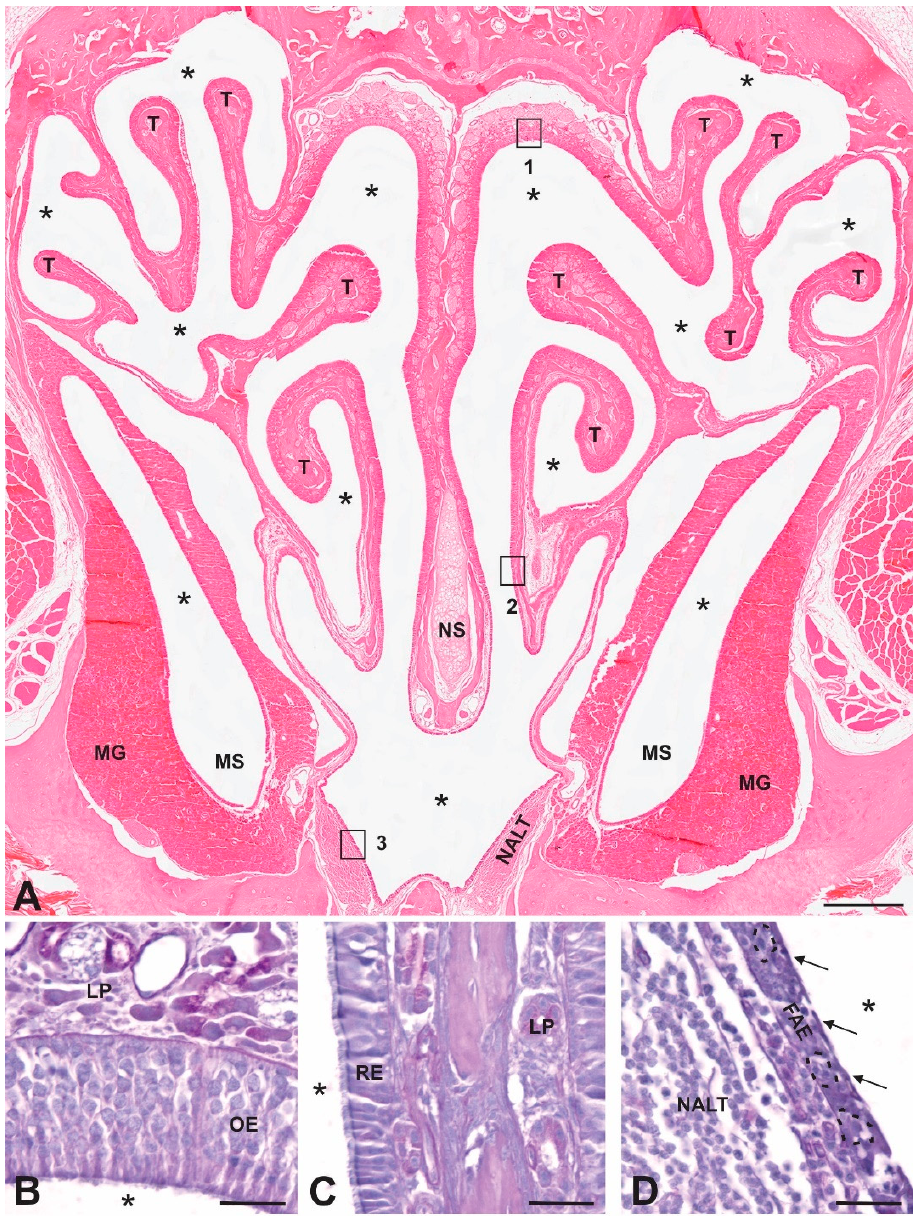
Figure 1. Anatomy of mammalian nasal cavity. ( A ) H&E-stained coronal section of a decalcified hamster nasal cavity showing the bony and cartilaginous nasal septum in midline (NS) and the turbinate bones (T) that increase contact between inhaled material and the epithelia that line the cavity. Note the presence of extensive mucus glands (MGs) in the lamina propria surrounding the maxillary sinus (MS) and the unencapsulated nasal associated lymphoid tissue (NALT) in the floor of the NC. Asterisks mark airspaces. Boxes 1–3 are enlarged in panels B – D , respectively. ( B ) Olfac ‐ tory epithelium (OE) lines the upper part of the NC and contains olfactory sensory neurons with dendrites that extend into the mucus layer of the NC airspace and axons that collect into nerve fascicles that form the olfactory nerve and project directly into the olfactory bulb of the brain. ( C ) Respiratory epithelium (RE) contains a single layer of pseudostratified ciliated columnar epithelial cells that overlay a loose connective tissue layer, the lamina propria (LP), that contains mucus glands and blood vessels. ( D ) Follicle ‐ associated epithelium (FAE) contains microfold cells (M cells; indi ‐ cated by arrows) that transport antigens in the NC to underlying lymphatic cells in intraepithelial pockets (dotted lines) and the nasal associated lymphoid tissue (NALT). Scale bars: A = 400 μ m; B, C, and D = 20 μ m.